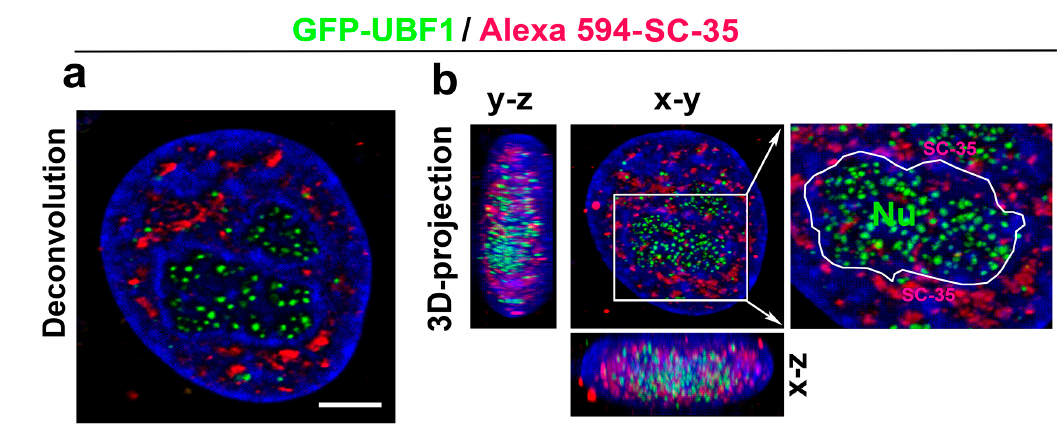
Figure 7. The spatial link between the SC-35 protein and the compartment of nucleoli. Nucleoli were visualized by GFP-tagged UBF1 protein (green), also playing a role in the nucleotide excision repair (NER) repair mechanism. Nuclear speckles were recognized according to the Alexa 594-stained SC-35 protein (red). ( a ) HeLa cell nuclei were visualized by conventional confocal and deconvolution tool. Scale bar shows 5 µ m. ( b ) 3D-projection of confocal images is shown. The compartment of the nucleolus (Nu), decorated by the SC-35 protein, is enlarged. The nucleolus boundary was depicted according to the UBF-1 positivity and location of DAPI-dense chromatin (white contours).